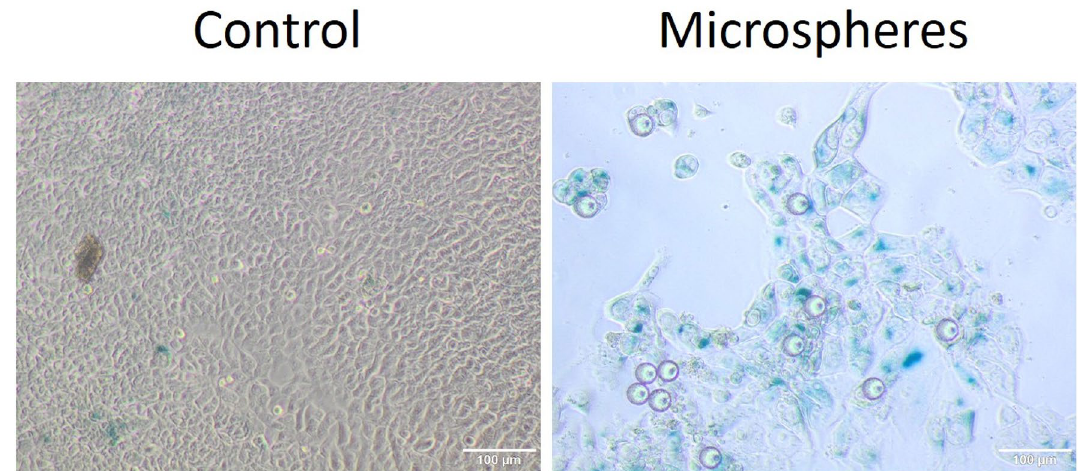
Figure 8. Detection of senescent cells using SA-β-gal staining in normoxia after 96 h (right: control, left senescent cells in culture growth with 90Y